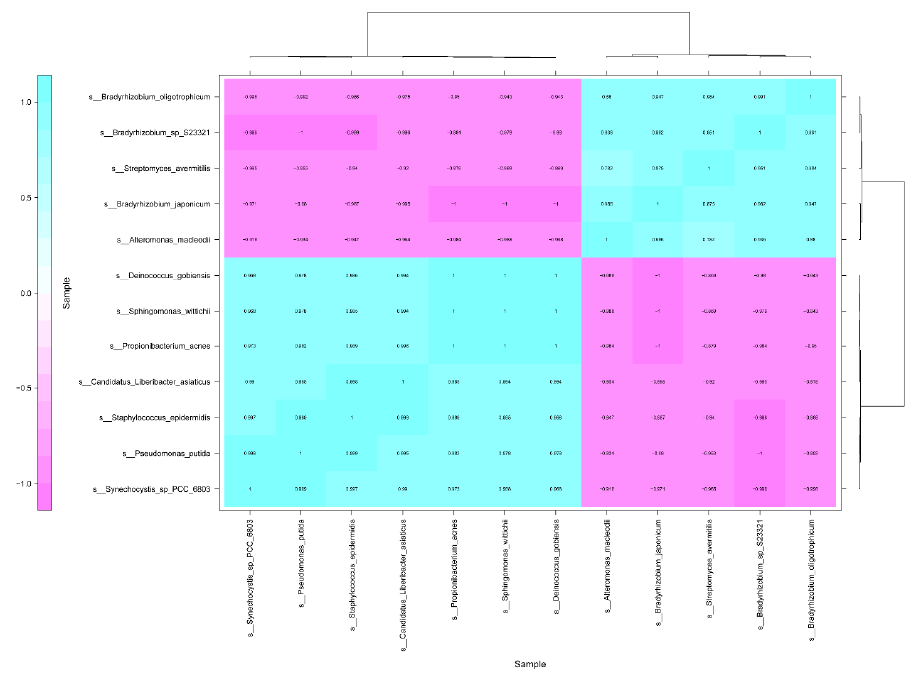
Figure 3. Correlation analysis of Candidatus Liberibacter asiaticus between other bacterial species in HLB-affected citrus leaves in response to the antibiotics.